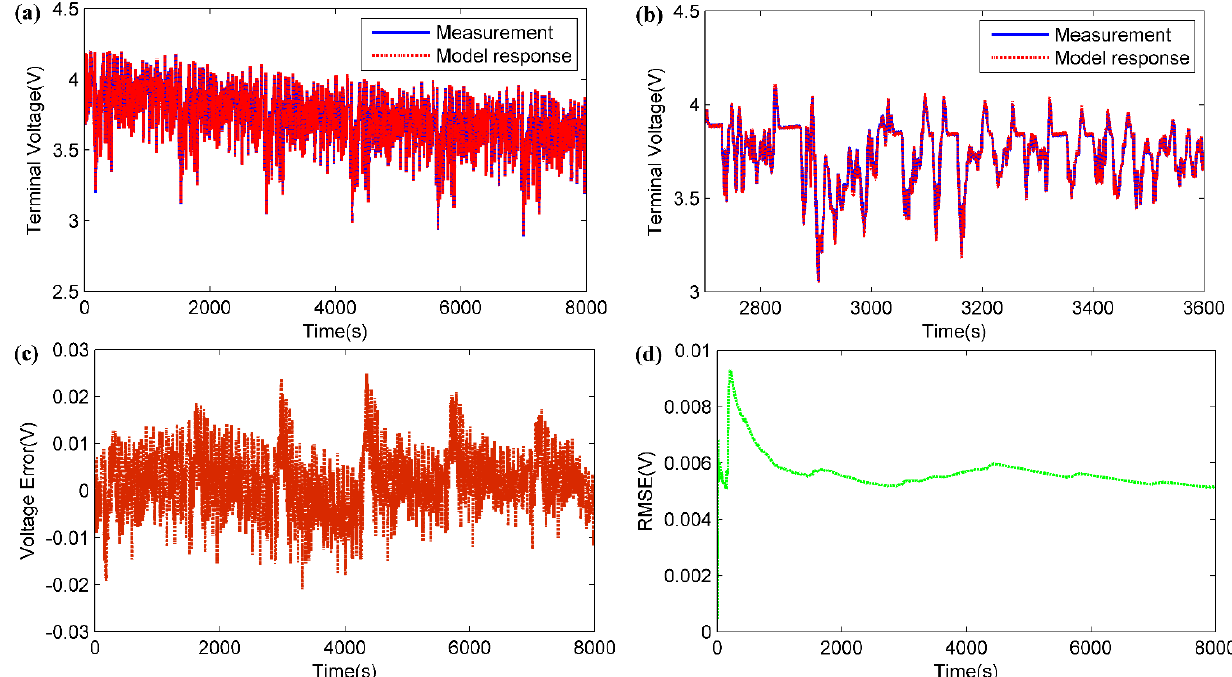
Figure 6. Model validation results of LCO cell: ( a ) Comparison of model output voltage and measured voltage; ( b ) Zoom plot; ( c ) Voltage error; ( d ) RMSE of voltage error.